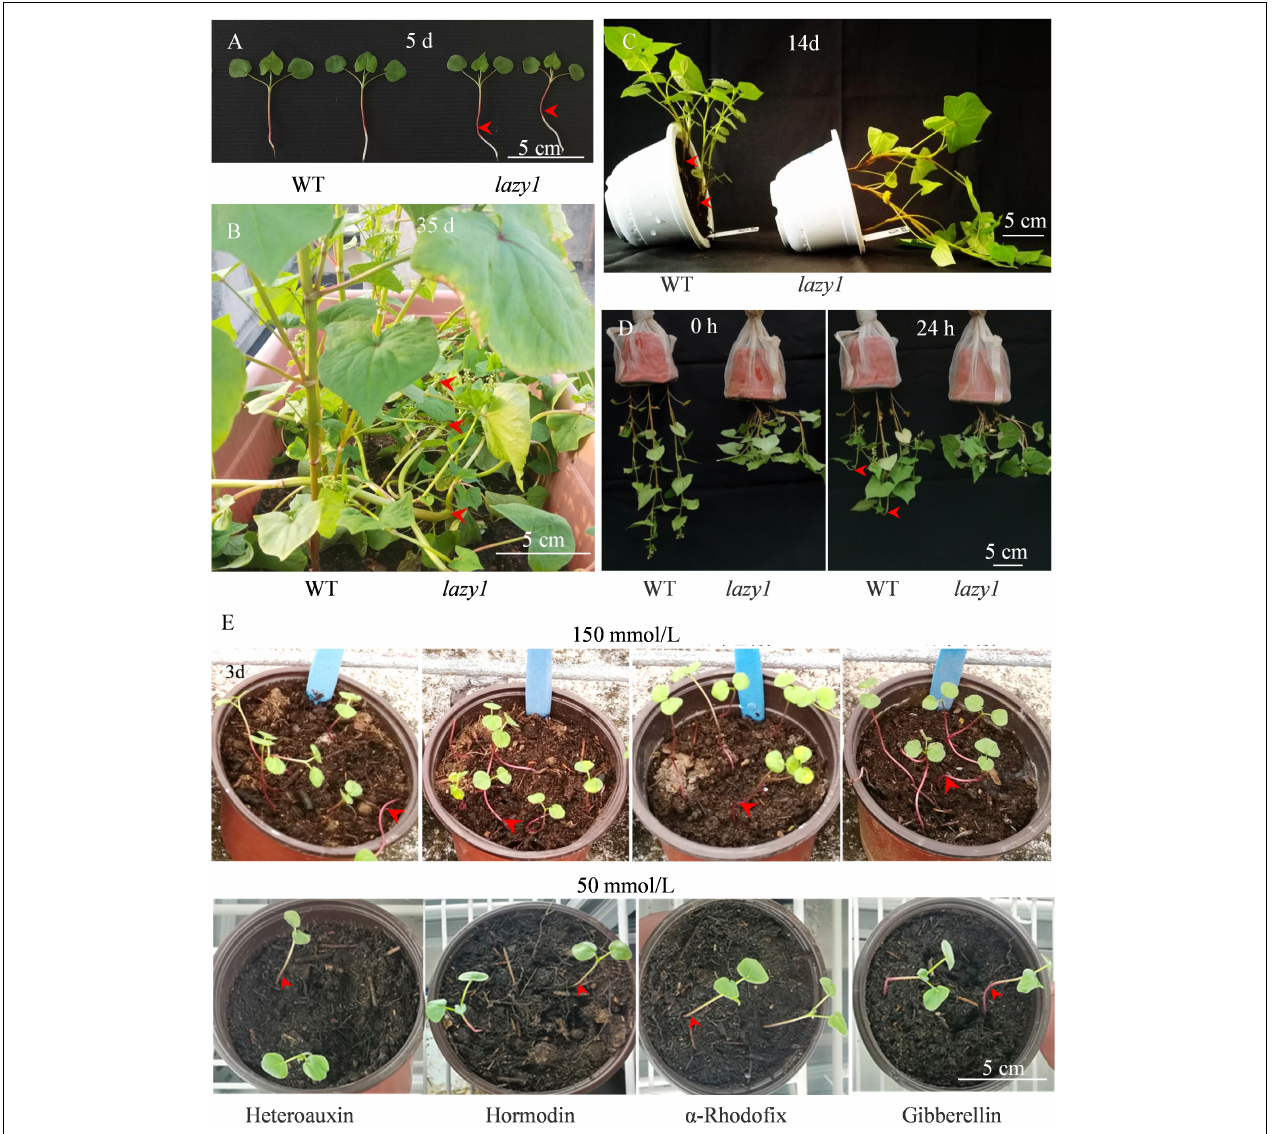
FIGURE 1 | Phenotypic observation of lazy1 plant at 5 (A) and 35 days (B) after germination, 14 days after horizontal treatment (C) , 0 and 24 h after inverted suspension treatment (D) , and 3 days after exogenous hormone treatment (E) . Red arrows point to the bending stem. Scale bar = 5